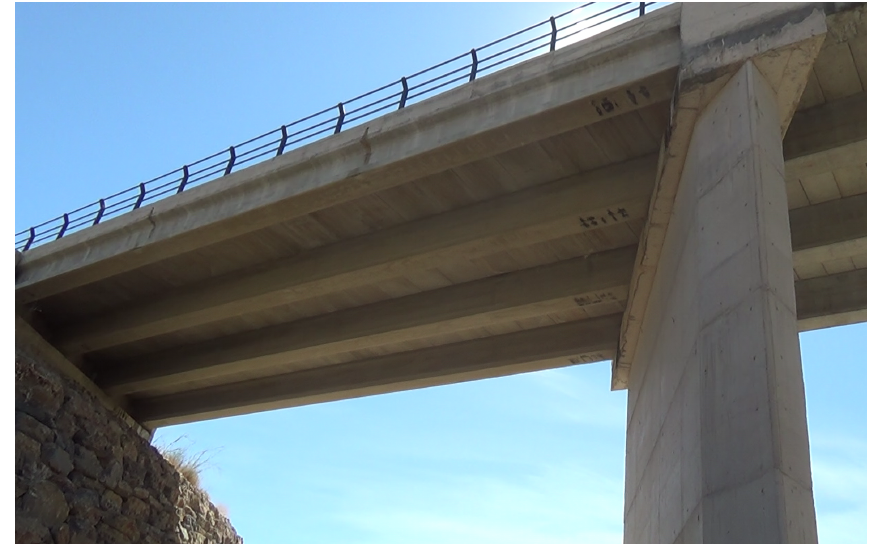
Figure 10. Grazalema